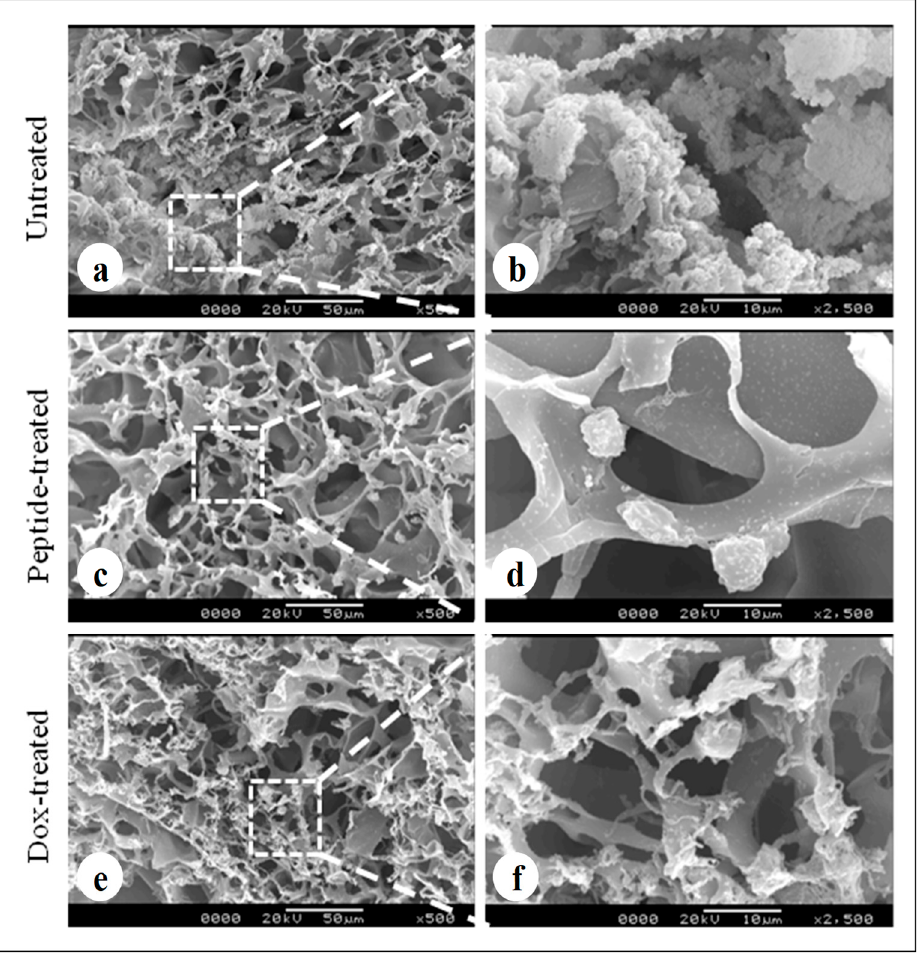
Figure 6. Cell loaded 3D silk constructs displaying treated and untreated conditions: a ) and b ) MDA ‐ MB ‐ 231 cells loaded silk fibroin construct without treatment, c ) and d ) peptide treated (cyclosaplin, 100 μ g/mL) MDA ‐ MB ‐ 231 cells on A. mylitta silk fibroin, e ) and f ) doxorubicin (100 μ g/mL) treated MDA ‐ MB ‐ 231 cells on A. mylitta silk fibroin. Scale bar = 50 and 10 μ m.